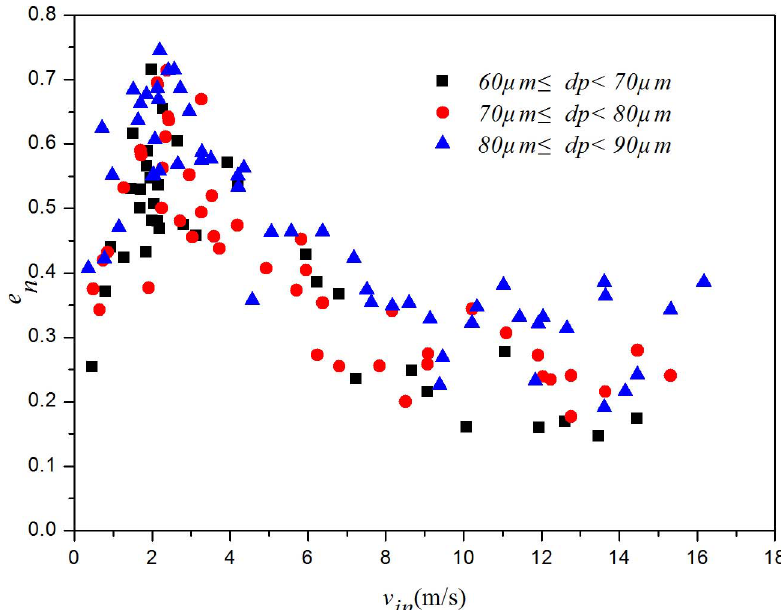
Figure 9. The normal restitution coefficient, e component, v , for the normal impact of fly ash particles diameter of 60–90 μ in